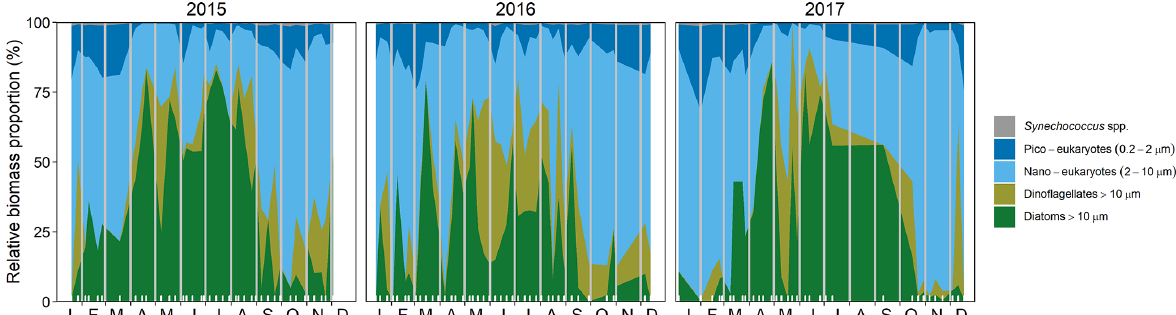
Figure 3. Seasonal changes in the proportional biomass of different phytoplankton groups from 2015 to 2017. The large proportional biomass of nano-eukaryotes in October–beginning of December 2017 corresponds mainly to a Phaeocystis spp. bloom. Inner white tick marks on the x -axis indicate those dates when data were collected, and data gaps at the beginning and end of each year appear as vertical white